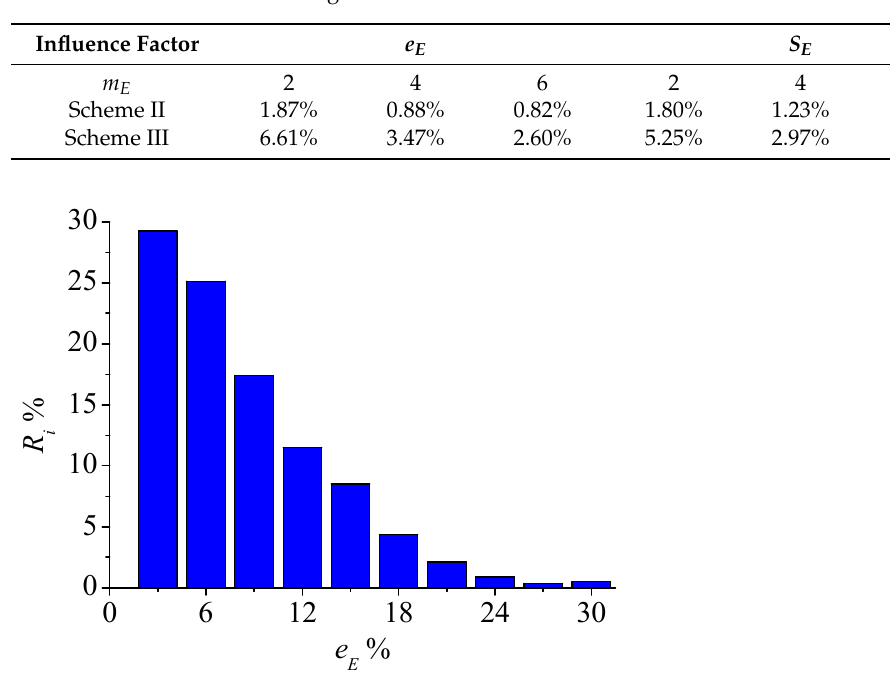
( b ) Figure 4. ( a ) The mean value and ( b ) standard deviation of relative error of Young’s modulus field of Scheme I. Young’s modulus field inversion results of schemes II and III were listed in Table 2.